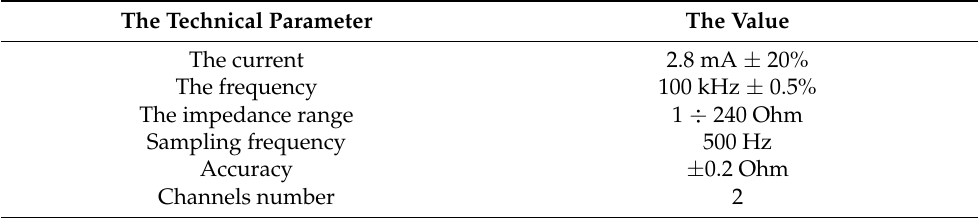
Table 2. Technical specification of the measuring system ReoCardioMonitor.